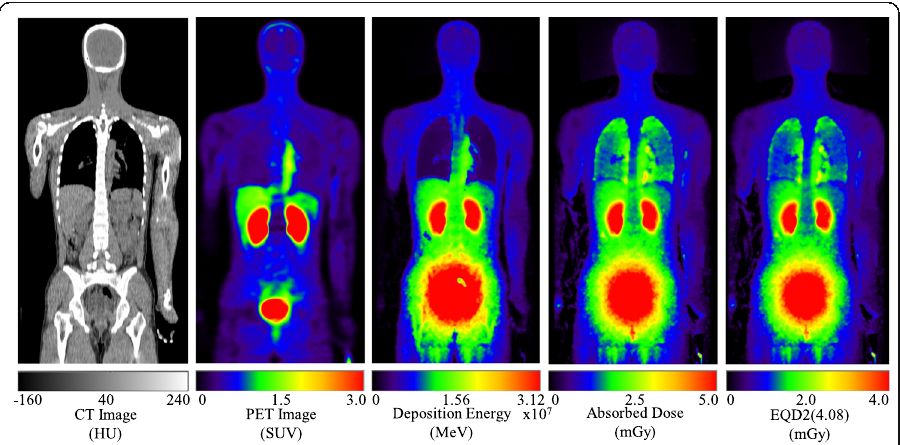
Fig. 3 Representative CT and PET images (90 min average) of a volunteer after the injection of NKO-035 labeled with 18 F and the corresponding deposition energy, absorbed dose, and EQD2(4.08) maps obtained from